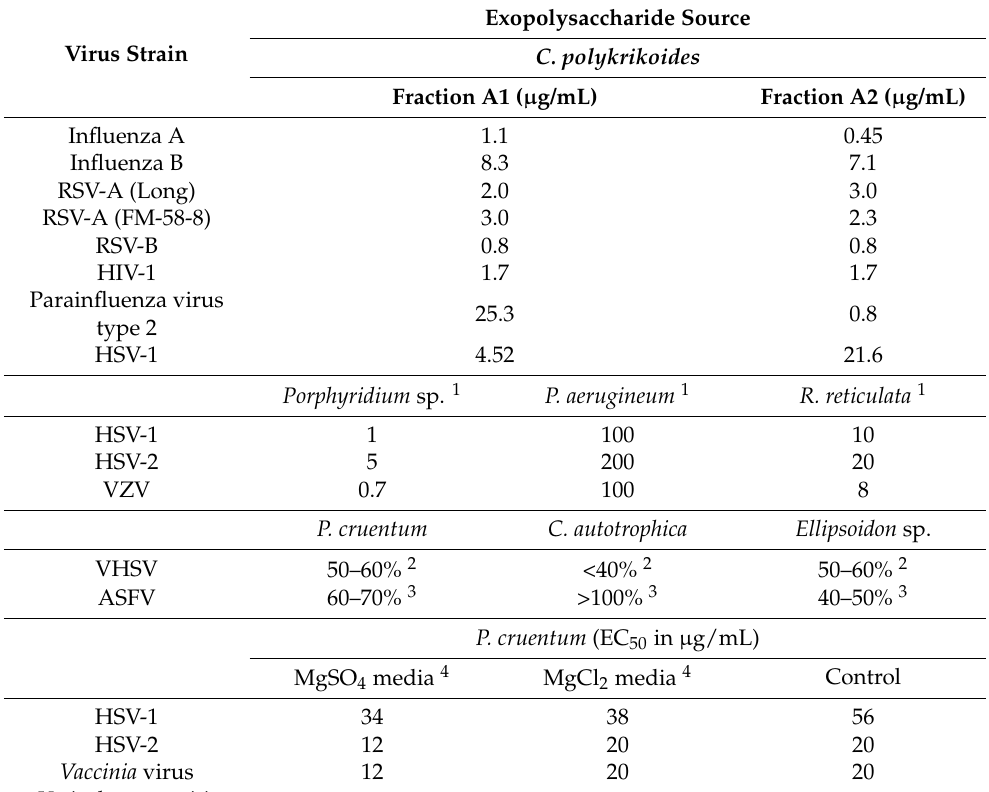
Table 6. Antiviral activities of various sources of